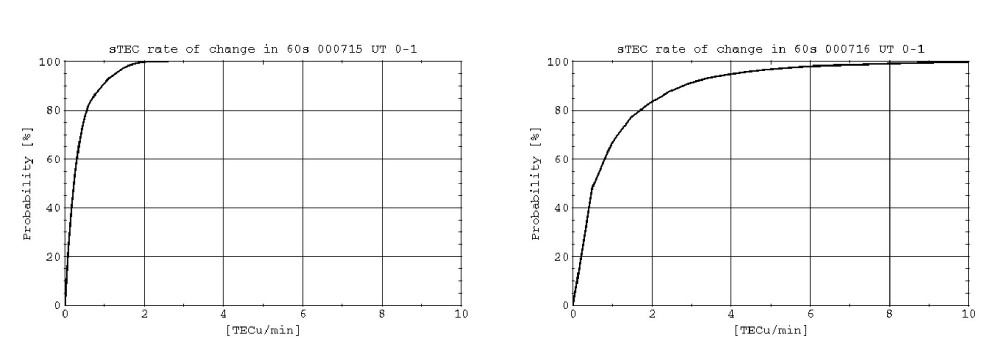
Fig. 18.7. Cumulative distributions of sTEC rate of change for July 15, 01:00 UT ( left ) and for July 16, 01:00 UT ( right ).